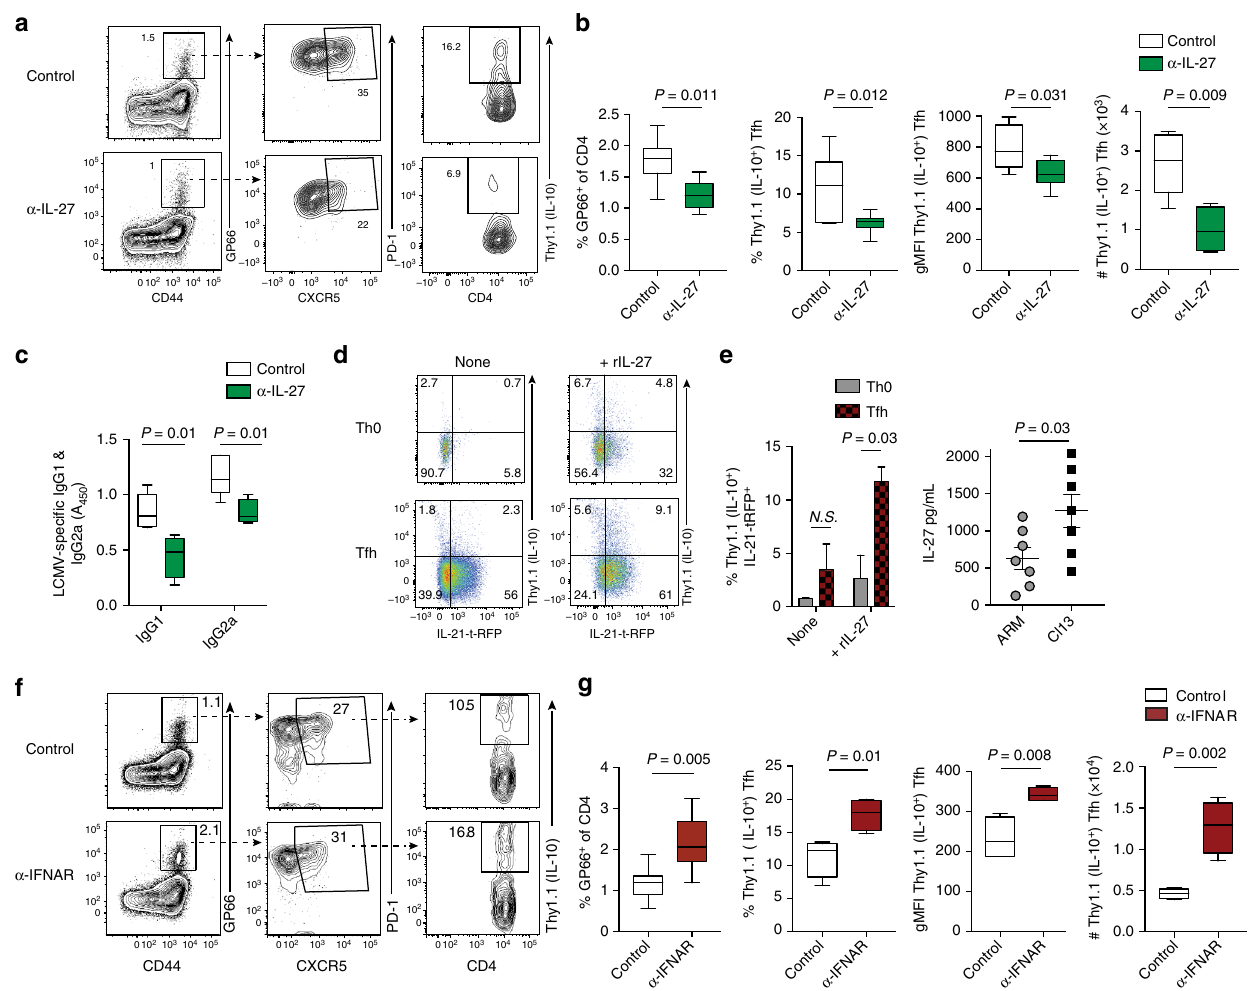
Fig. 6 IL-27 and type I IFNs differentially regulate IL-10 + Tfh development. a – c 10BiT-Il21-RFP mice were infected with LCMV Cl13 and treated with either isotype control or α -IL-27p28 blocking antibodies on days 3 and 9 p.i. a , b Representative fl ow plots ( a ) and summary data ( b ) depicting the proportion and total number of splenic Thy1.1 (IL-10) + GP66:I-A b -speci fi c Tfh cells from control and α -IL-27p28-treated mice on day 14 p.i. The relative expression (gMFI) of IL-10 (Thy1.1) in Tfh cells from experimental mice is also depicted in ( b ). c Summary graph showing serum levels of LCMV-speci fi c IgG1 and IgG2a on day 21 p.i. d Naive CD4 T cells were puri fi ed and cultured under Th0 or Tfh-polarizing conditions in the presence or absence of recombinant IL-27. Flow plots (left) and summary data (right) showing the proportion of Thy1.1 (IL-10 + ) IL-21-tRFP + cells after 3 days of in vitro culture. e WT mice were infected with LCMV Arm or LCMV Cl13. ( e ) Summary graph showing serum levels of IL-27 in experimental mice on day 7 p.i. f , g 10BiT-Il21-RFP mice were infected with LCMV Cl13 and treated with either isotype control or α -IFNAR blocking antibodies on days 10, 14, and 18 p.i. f , g Representative fl ow plots ( f ) and summary data ( g ) depicting the proportion and total number of splenic Thy1.1 (IL-10) + CXCR5 + PD-1 + GP66:I-A b -speci fi c Tfh cells from control and α - IFNAR-treated mice on day 21 p.i. The relative expression of IL-10 (Thy1.1) in Tfh cells from experimental mice is also shown in g . Summary data (box and whisker plots showing median (midline) and interquartile range with upper and lower whiskers representing the range of data distribution in b , c , and g or mean + /- SEM in d , e ) are from 3 to 5 mice/group and are representative of two to three independent experiments. * P < 0.05, ** P < 0.01, *** P < 0.0001. Data were analyzed using two-tailed unpaired student ’ s t tests. See also Figure